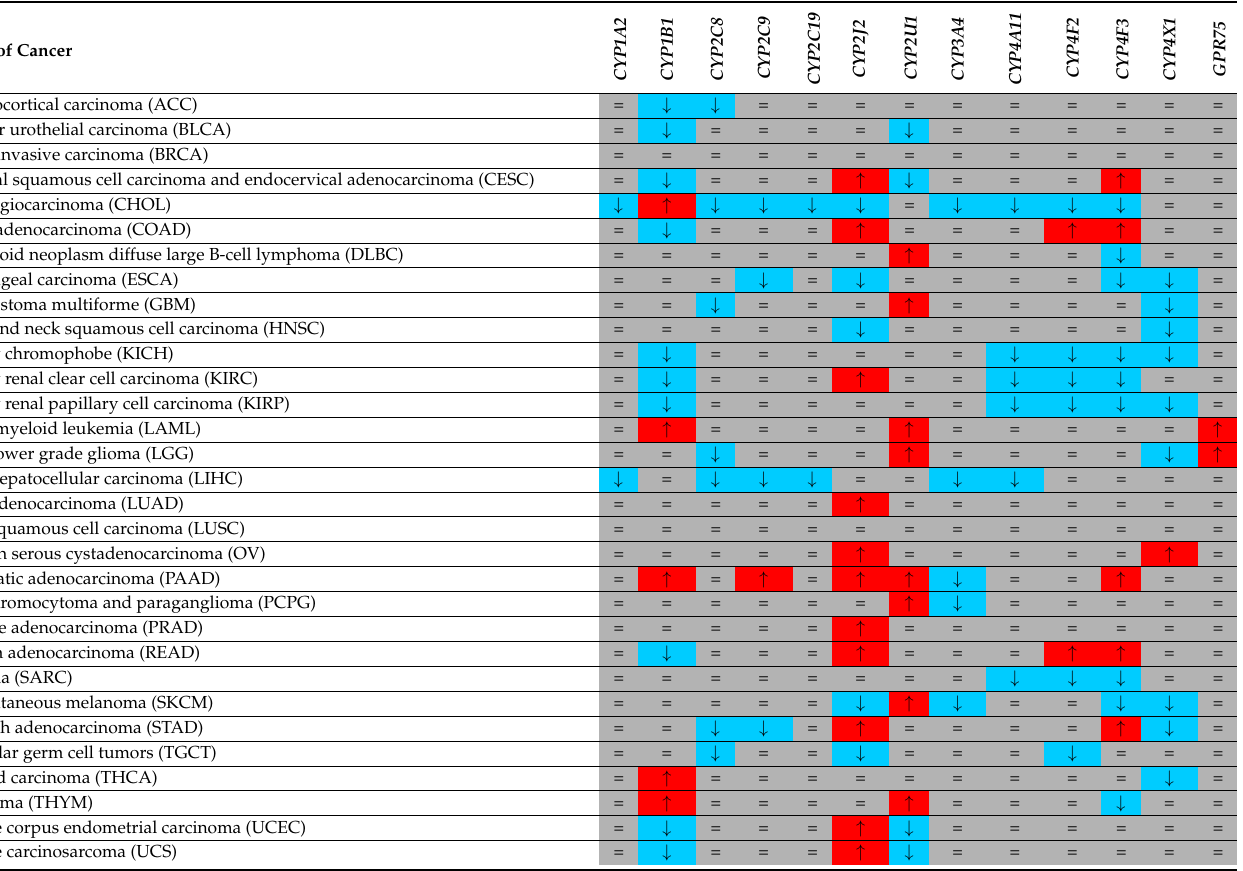
Table 10. Pan-cancer analysis of the expression of the cytochromes P450 and GPR75 receptor genes in